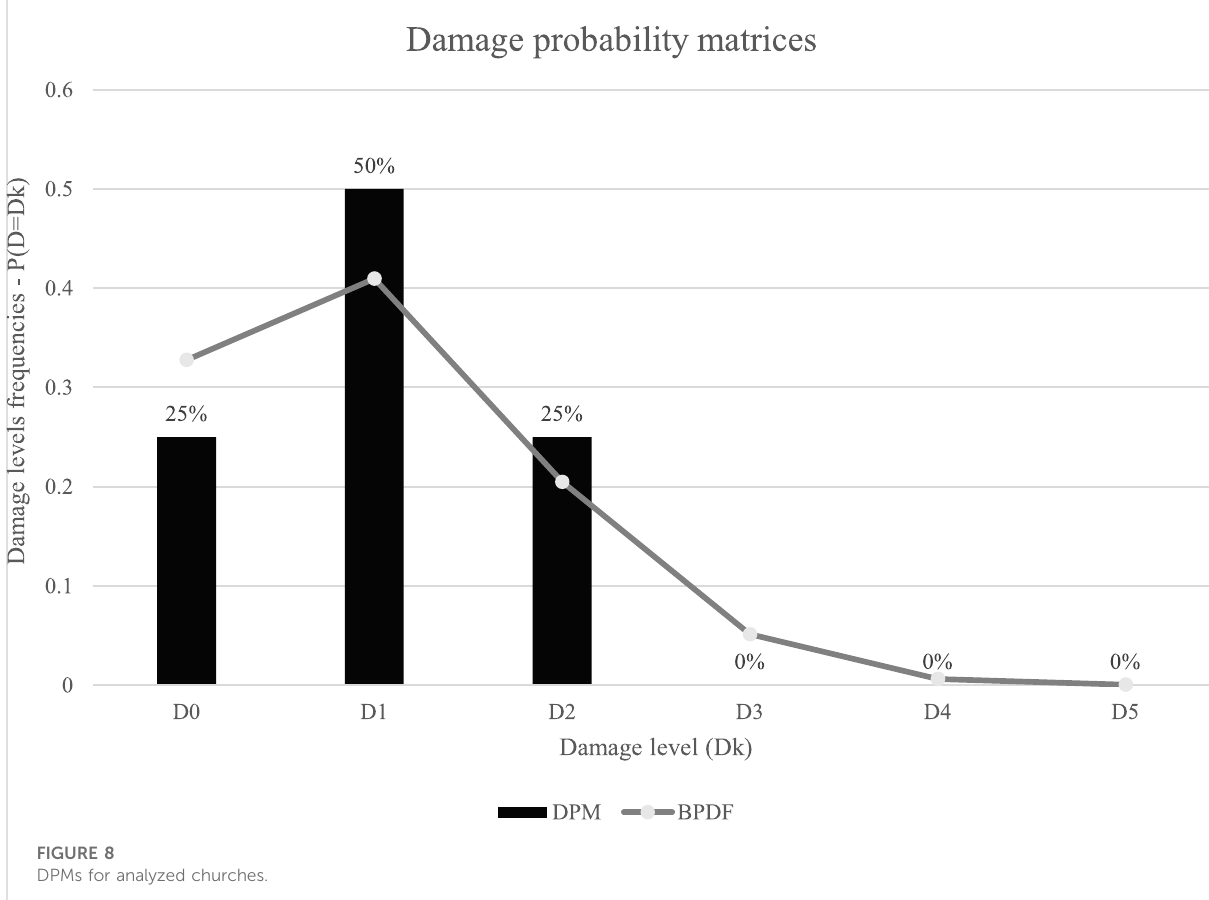
FIGURE 8 DPMs for analyzed